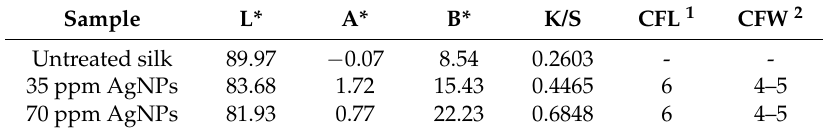
Table 1. Color coordinate data (CIE Lab) and K/S values of untreated and AgNPs-treated silk.